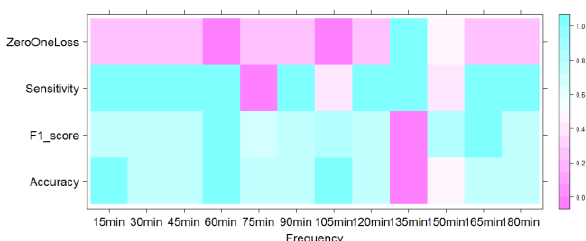
Figure 7. Levelplot of the time series classification metrics (Accuracy, F1_score, Sensitivity, ZeroOneLoss) across the entire range of frequencies